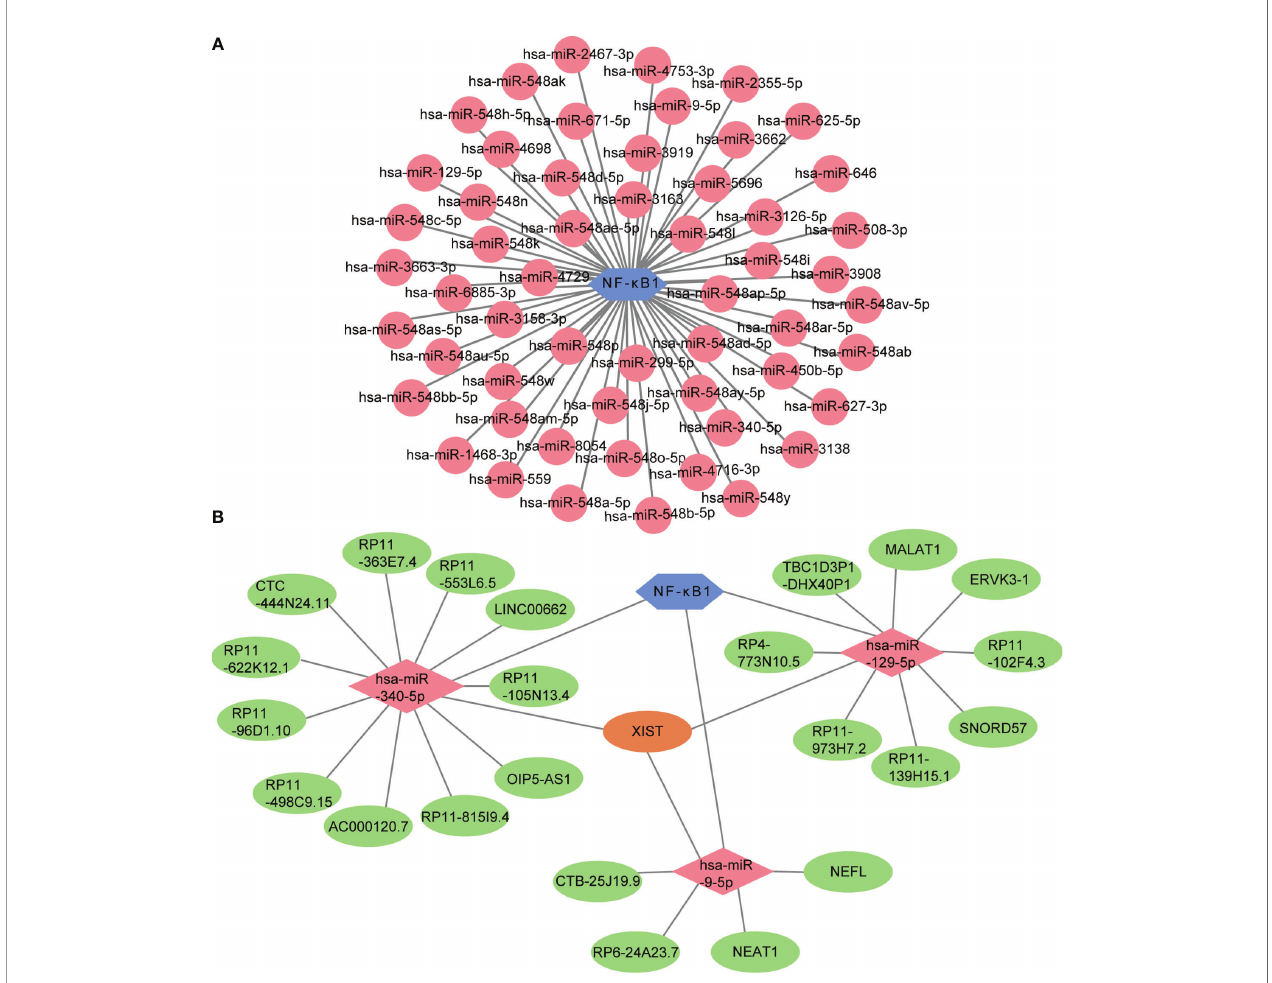
FIGURE 9 | Prediction of miRNA-mRNA network and ceRNA network. (A) The miRNA-mRNA network included NF- k B (blue hexagon) and 55 regulatory miRNAs (pink circles). (B) The lncRNA-miRNA-mRNA network was constructed, including three lncRNA-miRNA subnetworks and XIST showed as the crossover point. The blue hexagon node, the pink diamond nodes, and the pale-green ellipse nodes represent the mRNA and miRNA, respectively. Apricot ellipse nodes represent crosstalk via